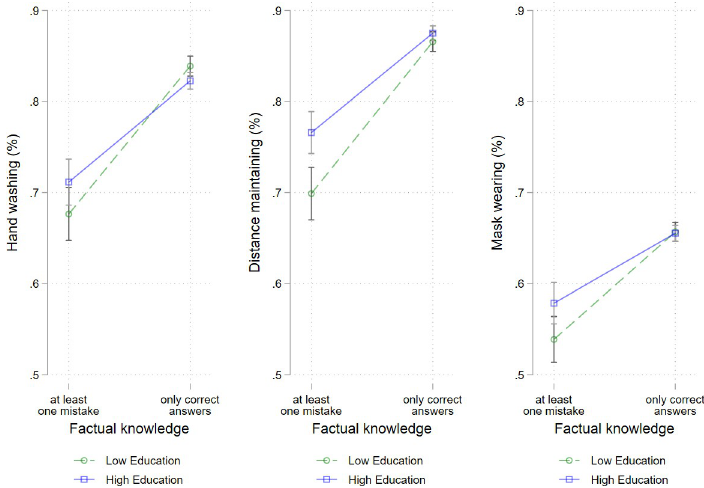
Fig 8. Protective behaviours by factual knowledge and education levels among men. Logistic regressions with interaction of factual knowledge and education level, adjusted for age group, repeat respondent, community size, and federal state, calendar week.